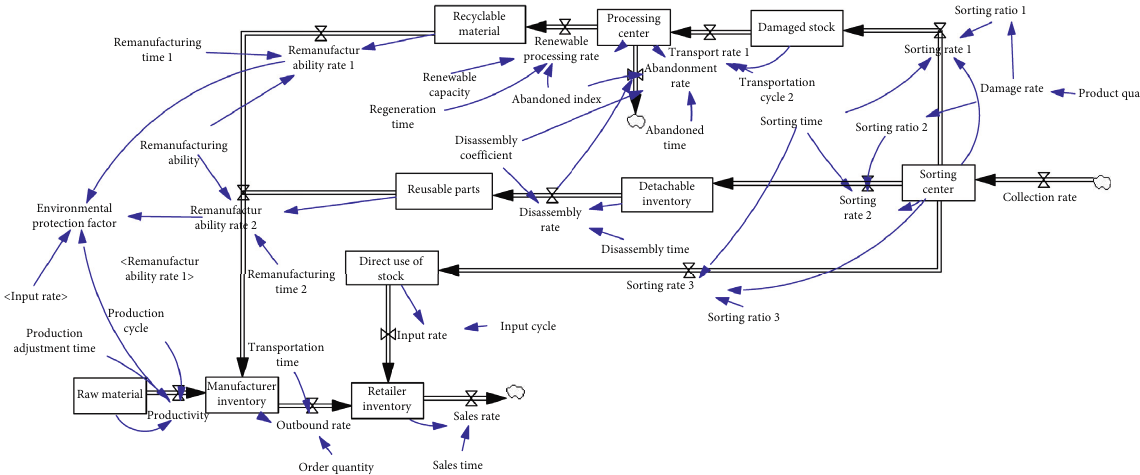
Figure 3: Classification processing system dynamics